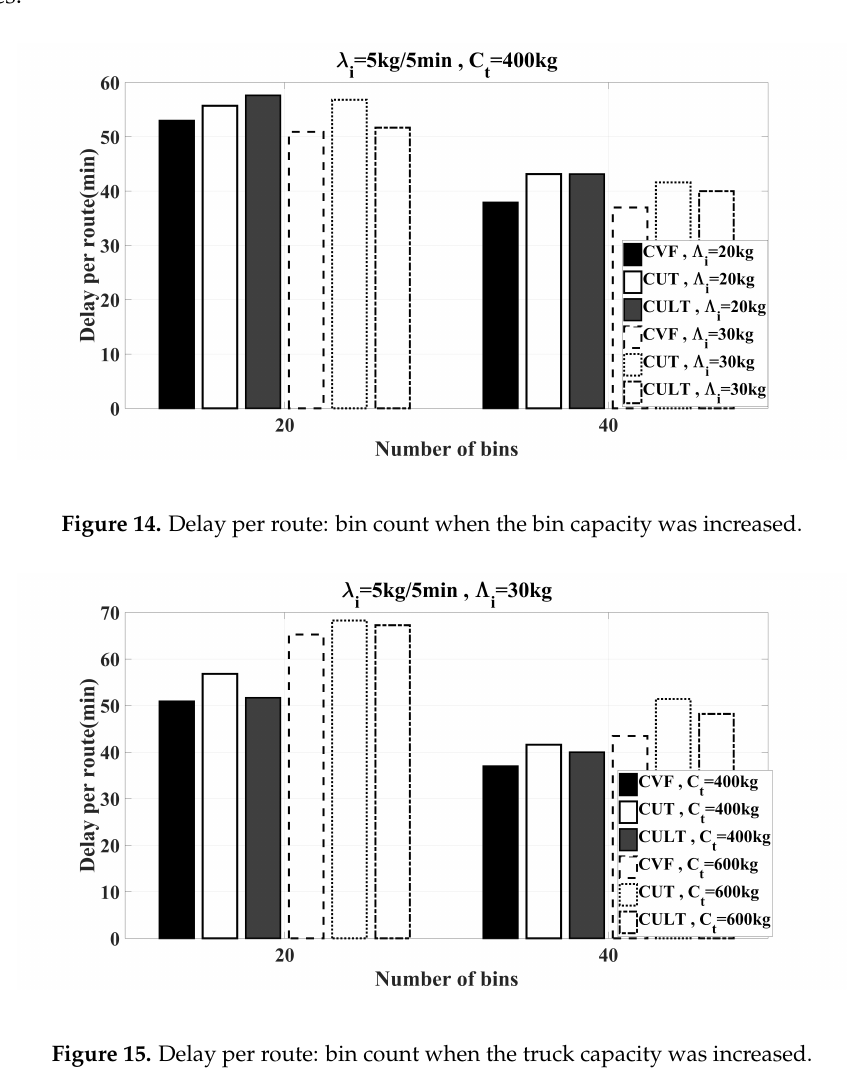
Figure 15. Delay per route: bin count when the truck capacity was